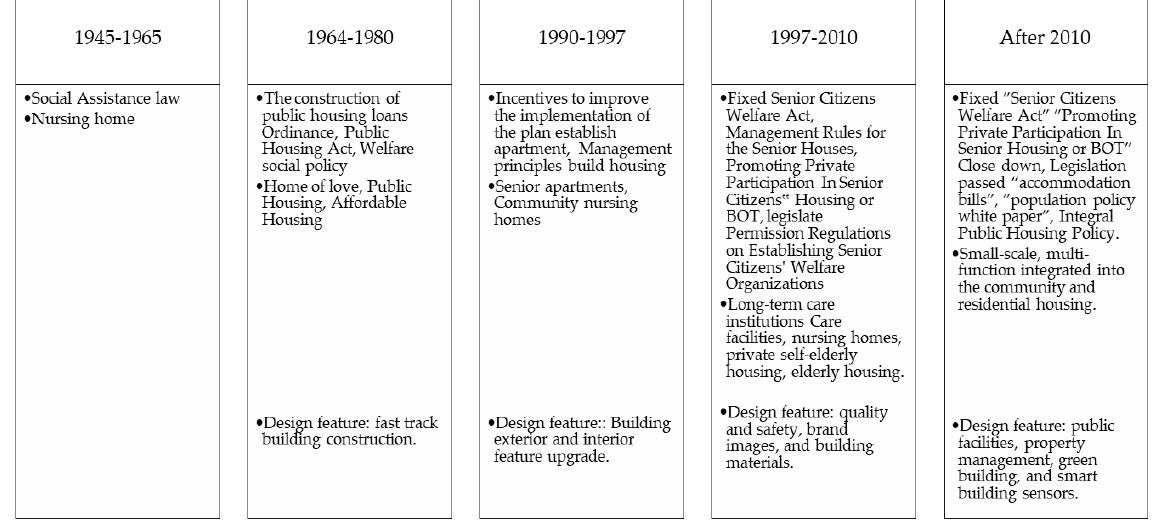
Figure 2. Development of dwelling feature thinking in Taiwan. Source: Lin, 2012, CEPD 2010.